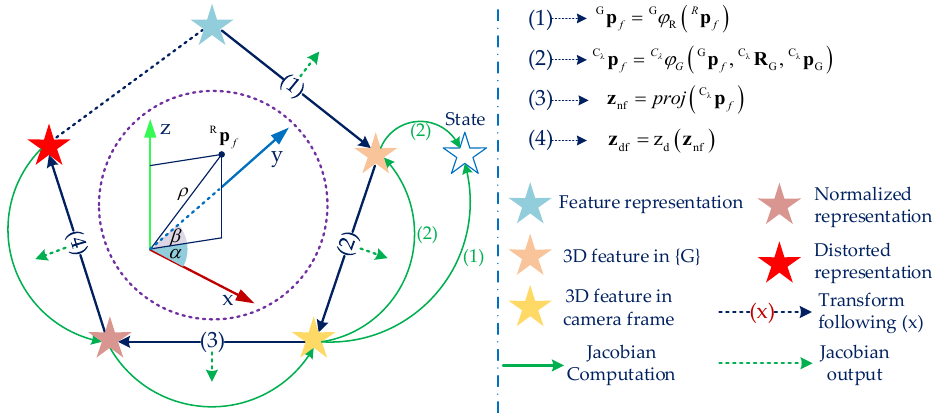
Figure 5. A demonstration of the transform between a 3D and 2D visual feature representation. The dark blue arrows indicate how to convert 3D feature representation to 2D data on the distorted image plane, and the green arrows show the processes to compute the Jacobian concerning a variable by using the chain rule of differentiation. Inside the brown circle presents the Anchored Inverse Depth model [7] of a visual